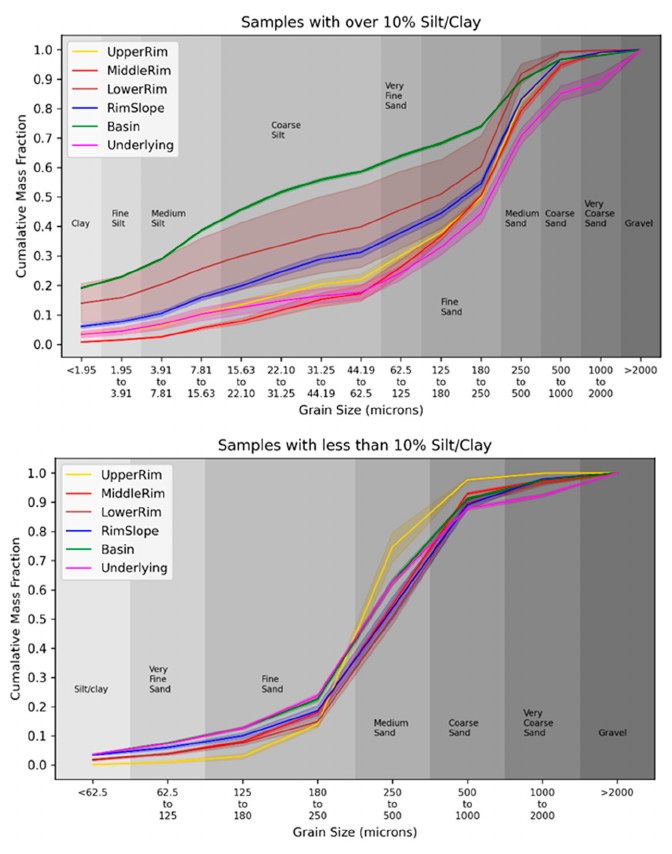
Figure 20. Grain size cumulative mass fractions with standard errors by sample type. Top: Grain size cumulative mass fractions for samples with more than 10% silt/clay. Bottom: Grain size cumulative mass fractions for samples with less than 10% silt/clay.